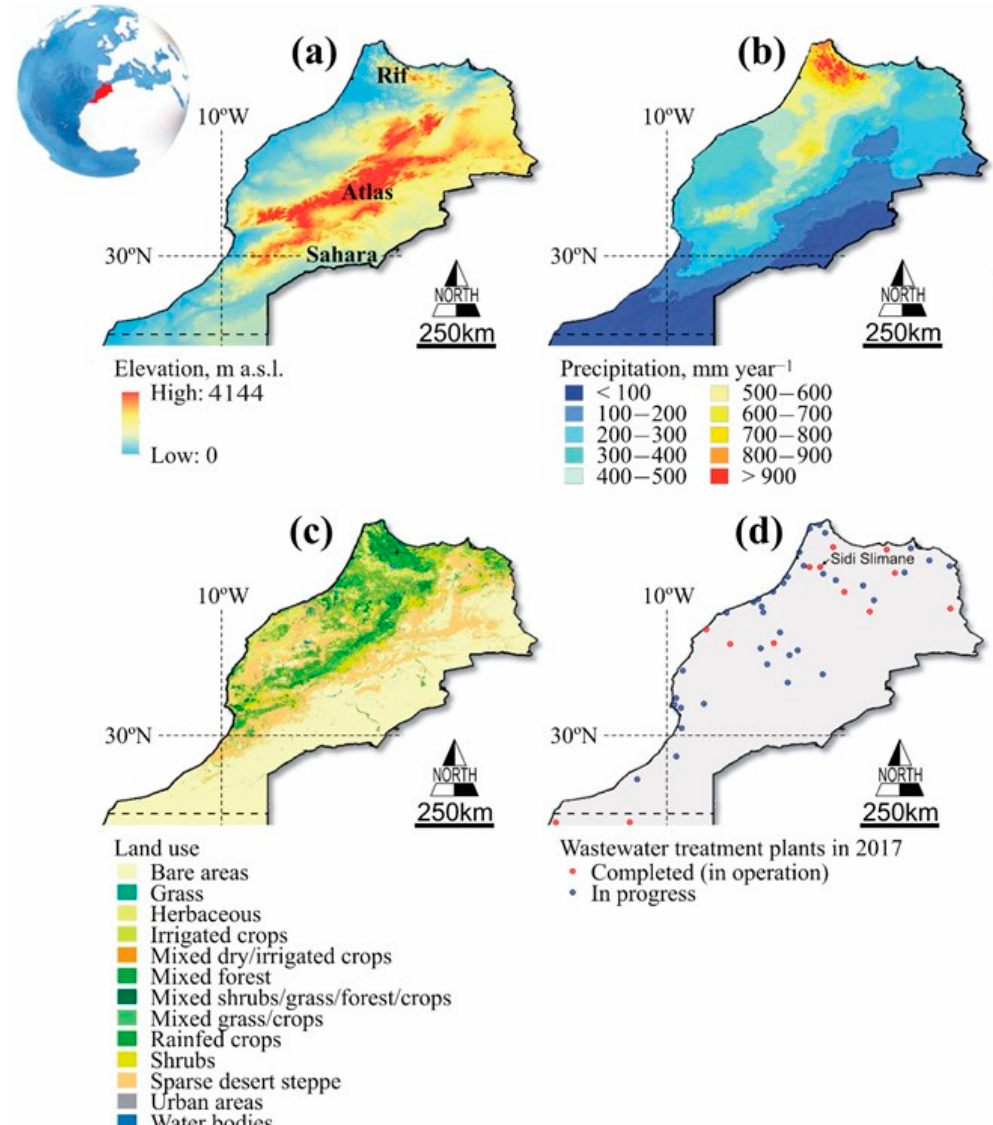
Figure 1. ( a ) Elevation, ( b ) precipitation, ( c ) land use, and ( d ) wastewater treatment plants in Morocco. The three first maps were modified from Gourfi et al. [38], whereas the latter was created from the PWNOW database (accessed on January 2017).